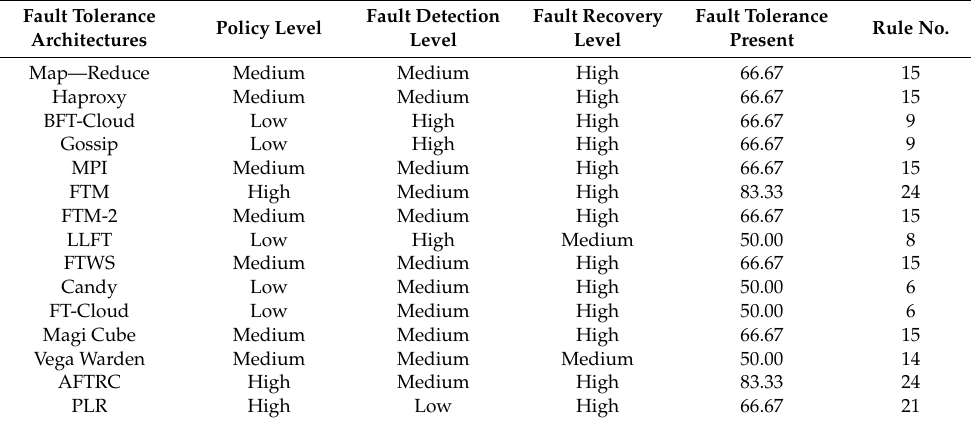
Table 9. Assessment results of the architectures in our proposed FIS (1) engine.